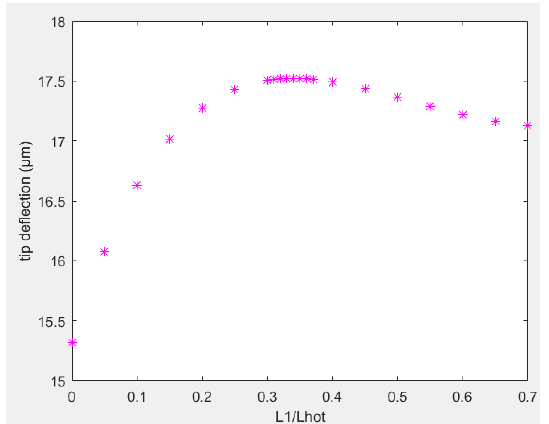
Figure 17. Tip deflection in function of length ratios of hot arm.